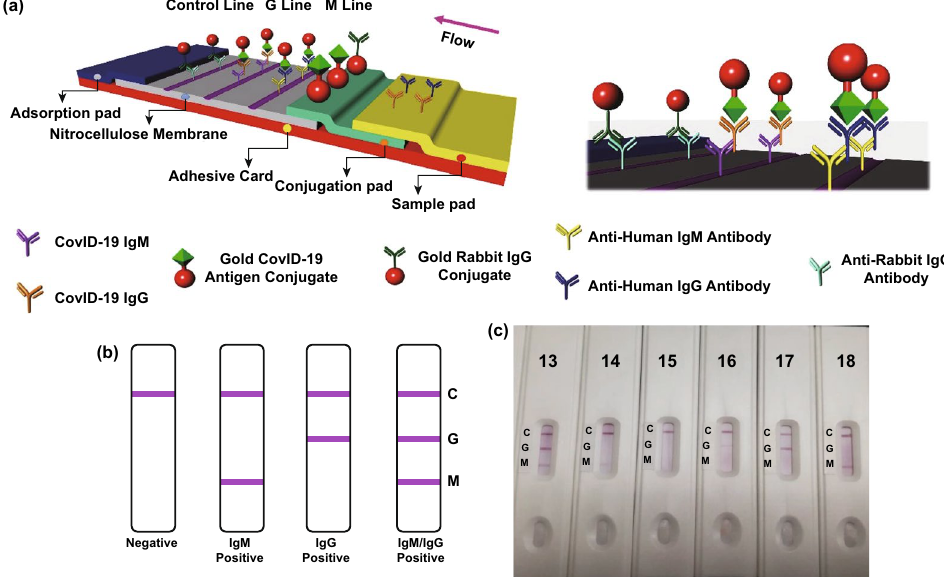
Fig. 12 Schematic explanation of quick SARS‑CoV‑2 IgM–IgG combined antibody test. a Schematic of the recognition device. b An explana‑ tion of various experimental consequences. c Relates to the control line, G means IgG line, M pertinent to IgM line. Illustrative photograph for various patient blood experimental consequences. #13 shows both IgG and IgM positive, #14 shows IgM weak positive, #15 illustrate both IgG and IgM negative, #16) IgG weak positive, #17) IgG positive, #18) IgM positive. (Redrawn from Ref.